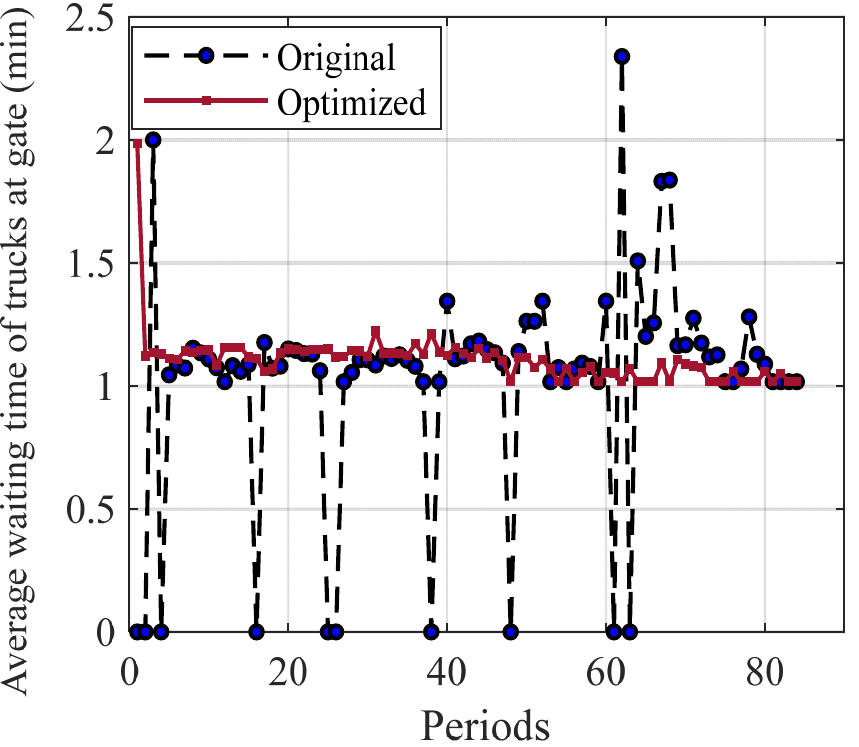
Figure 12. The comparison between truck waiting time at terminal gate in the original and optimized cases.